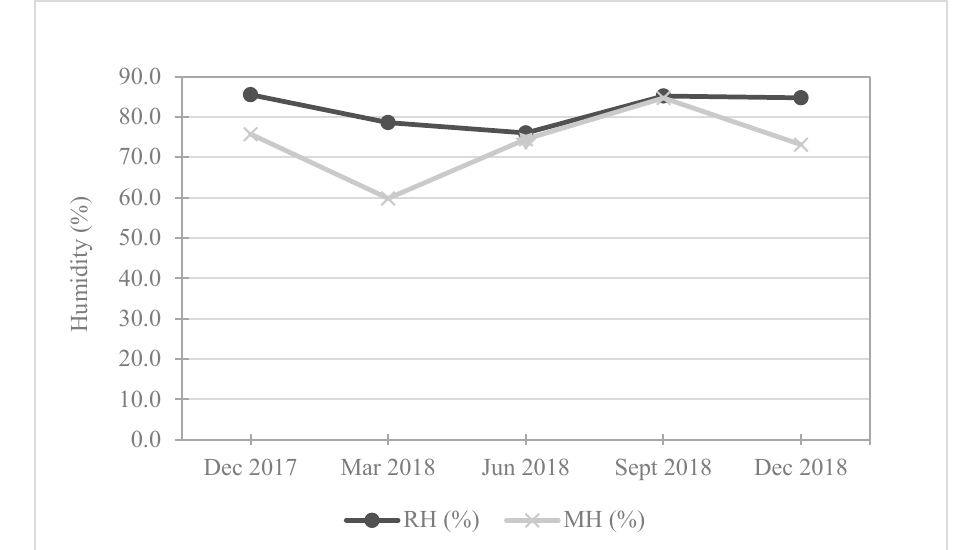
Figure 2. Macro- and microclimatic variables in the area of Yucatán, México, where the Gymnopodium floribundum plot was located. The values of the macroclimatic variables are the means for the 90-day period prior to the respective leaf harvest; the values of the microclimatic variables are the means for the 7 days prior to the respective leaf harvest. ( a ) TMP = mean ambient temperature, Tmin = minimum ambient temperature, Tmax = maximum ambient temperature, MT = mean temperature recorded at the level of the tree leaves (°C), ( b ) RF = accumulated rainfall (mm), and ( c ) RH = mean relative humidity.